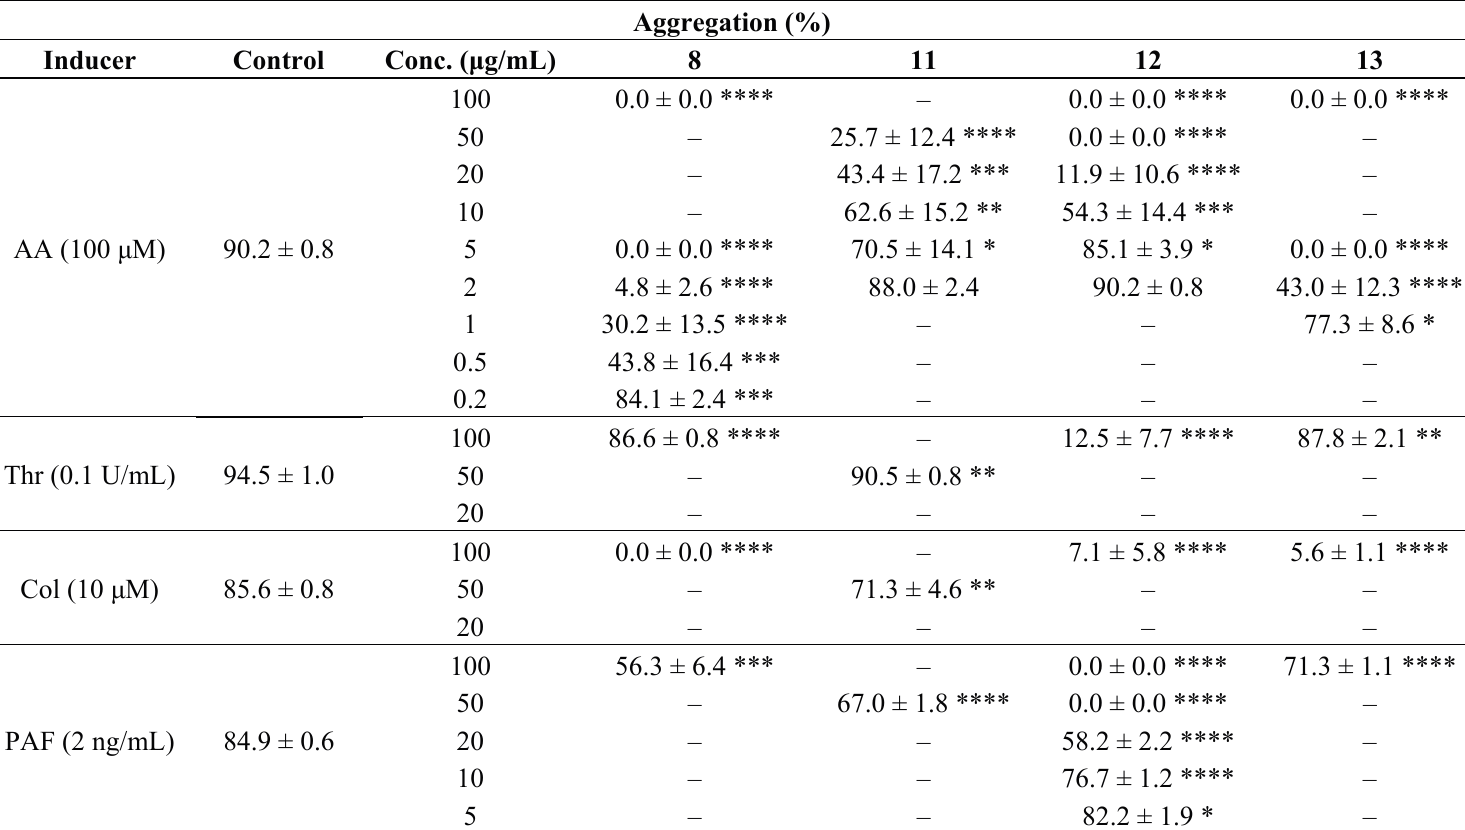
Table 3. Antiplatelet aggregation effects of 8 , and 11 – 13